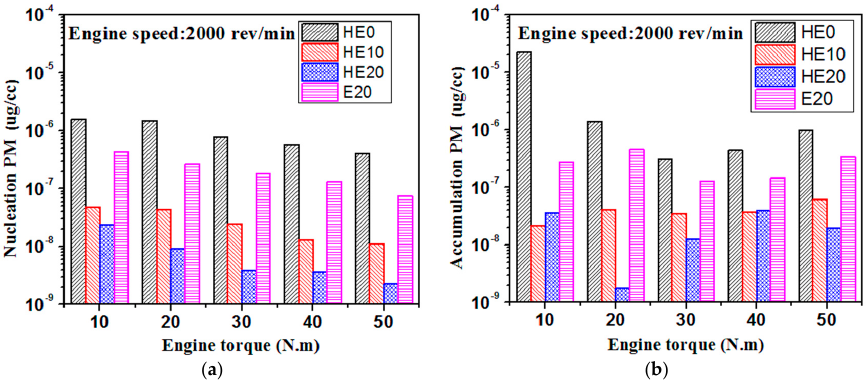
Figure 8. Variation of ( a ) nucleation mode; ( b ) accumulation mode mass particles with engine load.